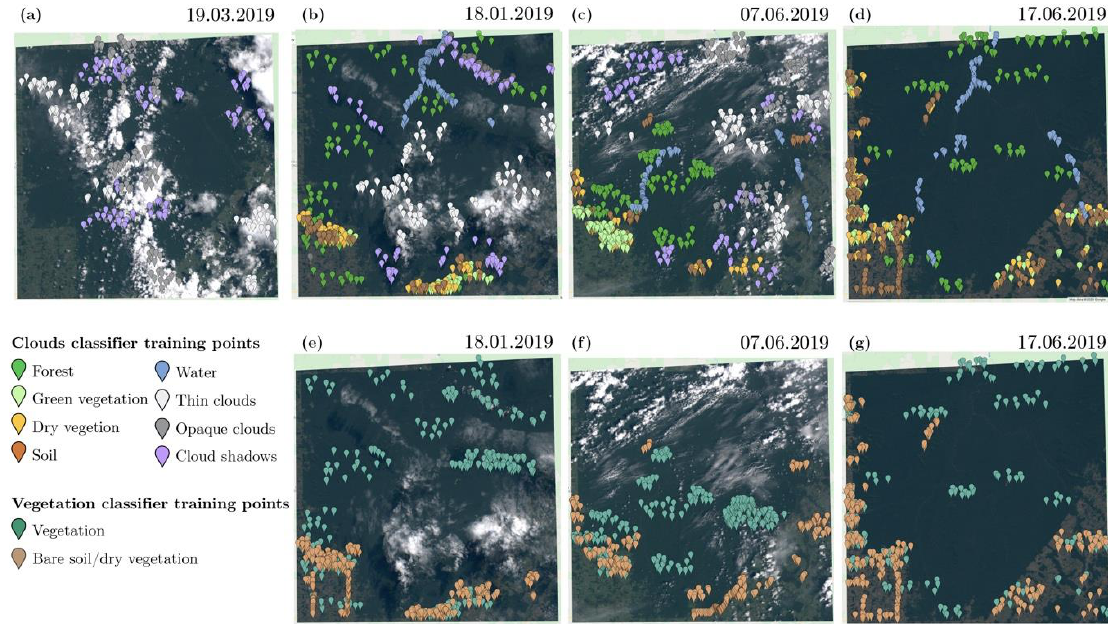
Figure 5. Labelled data used for training and validation of the Artificial Neural Network (ANN) classifiers: ( a – d ) labelled data used for the cloud and cloud shadow classifier; ( e – g ) labelled data used for the vegetation classifier.